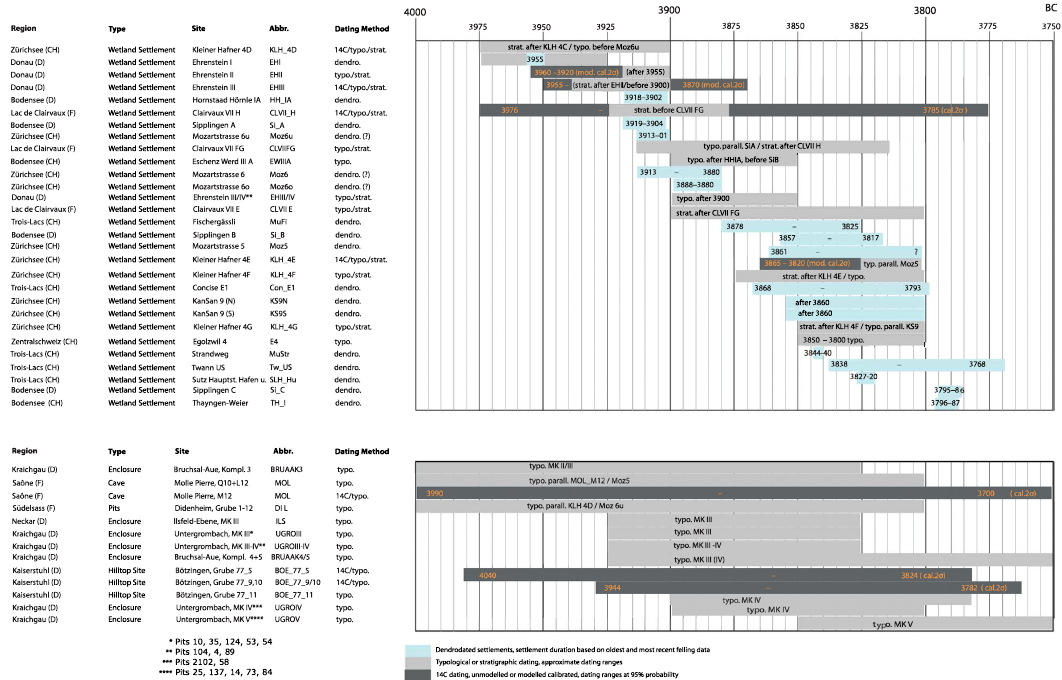
Figure 2: Temporal model of considered settlements and assemblages of pottery ( fi gure: after Heitz, 2018, Figure 5.7 ) . MK =